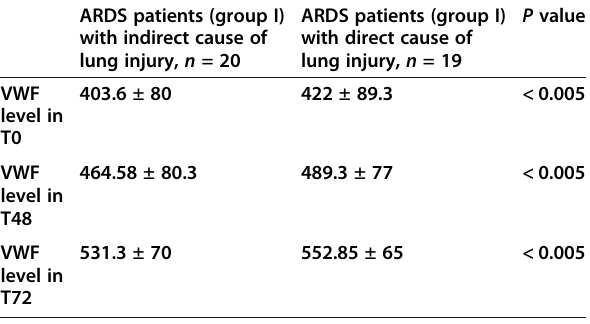
Table 2 Levels of vWF in Group I patients with direct and indirect causes of ARDS ARDS patients (group I) ARDS patients (group I) with indirect cause of with direct cause of lung injury, n = 20